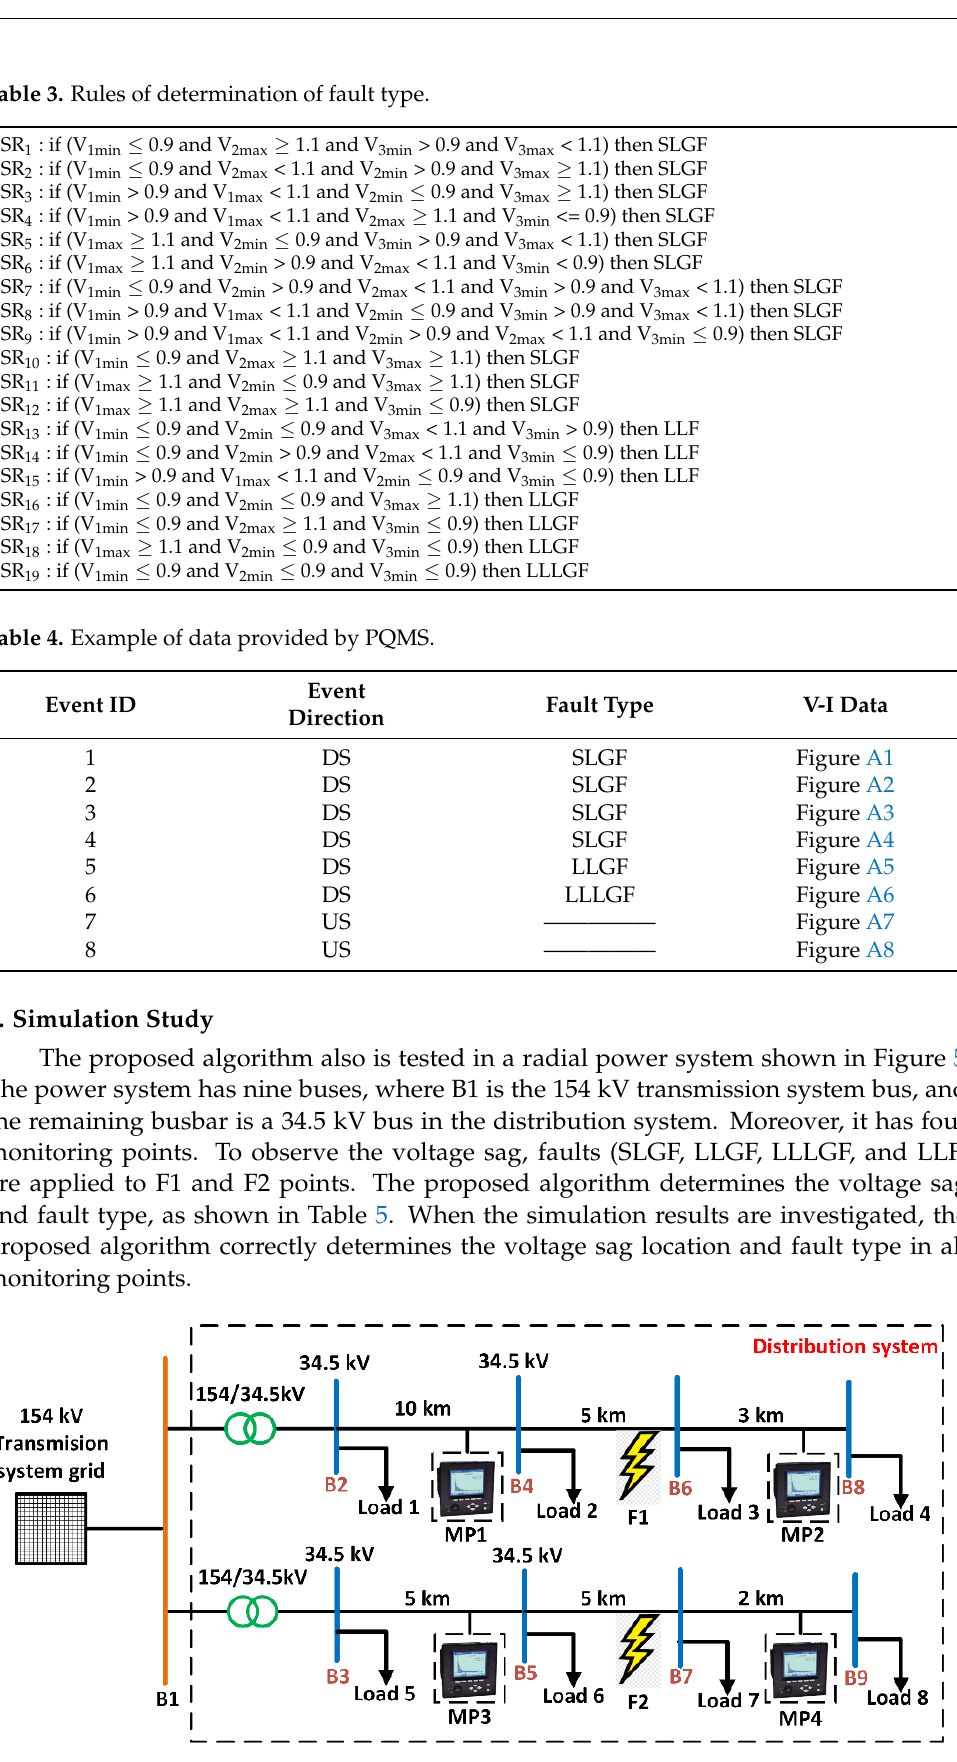
Figure 5. Test system. Table 5. Simulation